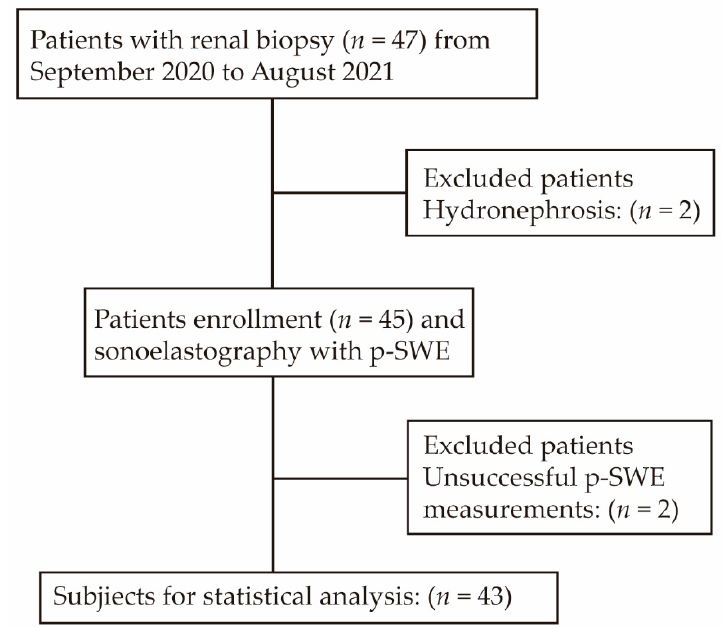
Figure 1. Flow chart of all